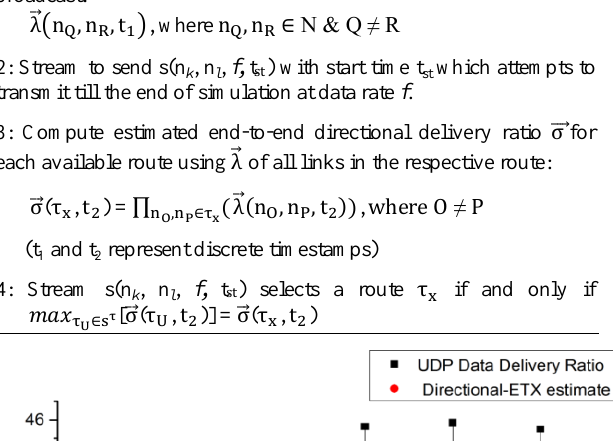
Algorithm 1 Directional Delivery Estimate and PDR